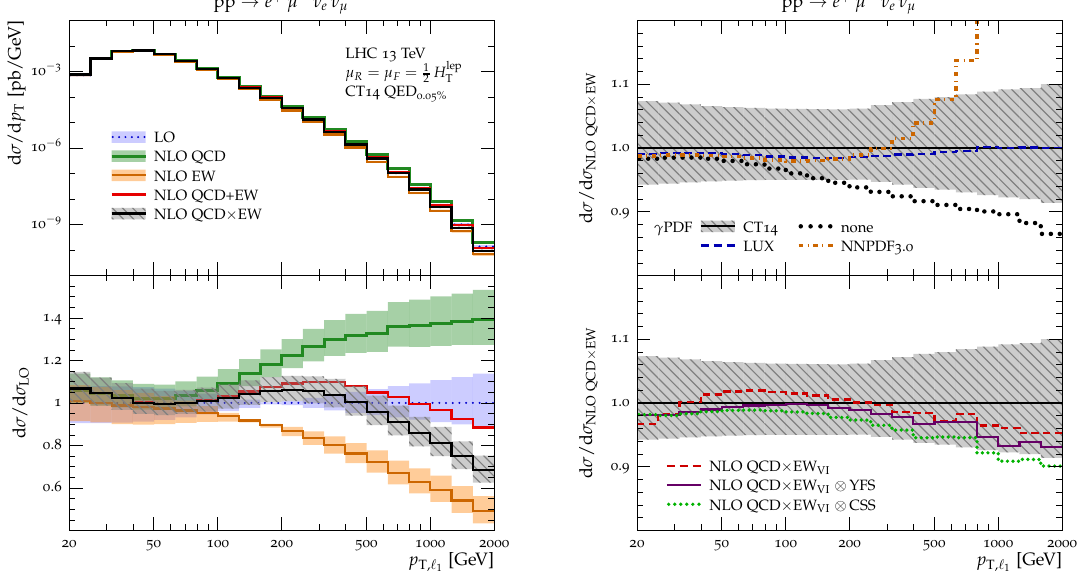
+ (cid:22) (cid:0) (cid:23) Figure 9 . Distribution in the transverse momentum of the leading lepton, p T ;‘ 1 , for pp ! e e (cid:22) (cid:23) (cid:22) at 13 TeV. The left panel shows the absolute predictions and relative corrections with respect to LO (including (cid:13)(cid:13) 2 ‘ 2 (cid:23) ) for the nominal CT14qed PDF. The bands correspond to factor-two scale ! variations. The upper-right panel shows the e(cid:11)ect, at NLO QCD EW level, of switching o(cid:11) (cid:13) - (cid:2) induced contributions or applying photon densities from di(cid:11)erent current PDFs, while using quark and gluon densities from the nominal CT14qed set throughout. The lower-right ratio shows the level of agreement of the NLO QCD EW VI , NLO QCD EW VI YFS and NLO QCD EW VI CSS (cid:2) (cid:2) (cid:10) (cid:2) (cid:10) approximations with the exact NLO QCD EW (cid:2)